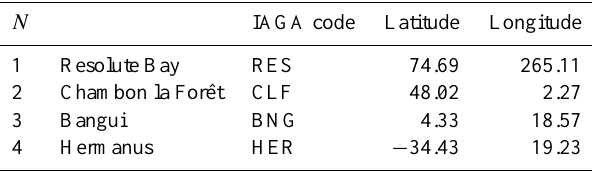
Table 1. The magnetic observatories used in this study.